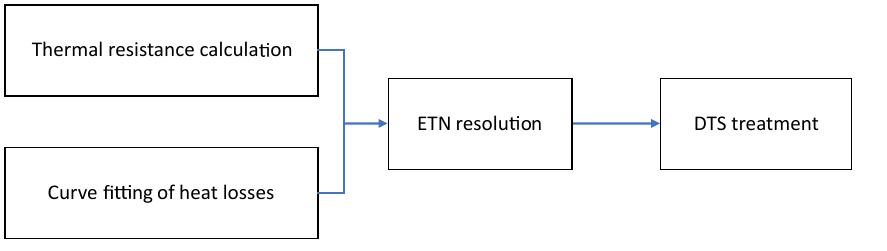
Figure 9. Flowchart of the proposed